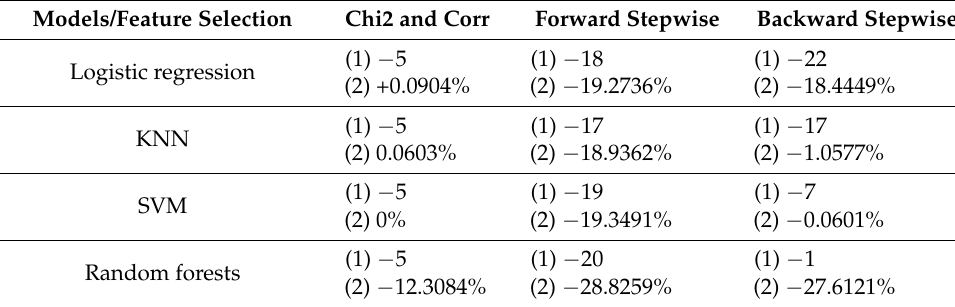
Table 7. The comparison of the results across all the